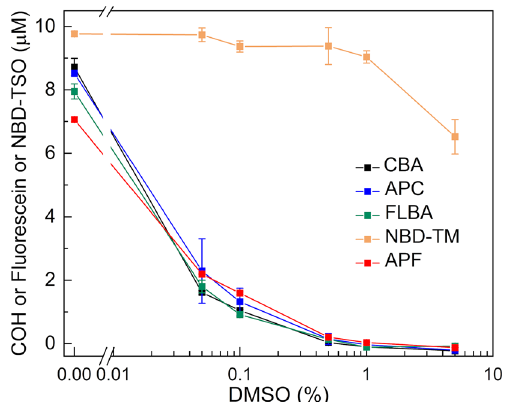
Figure 6. Effect of DMSO on detected HOCl concentrations by the CBA, APC, APF, FLBA, and NBD-TM probes. Incubation mixtures contained 20 µM of a probe, 10 µM HOCl, 0–5% v/v (0–0.7 M) DMSO, and 50 mM phosphate buffer (pH 7.4). (Representative result of three independent experiments is shown. Points represent means ±